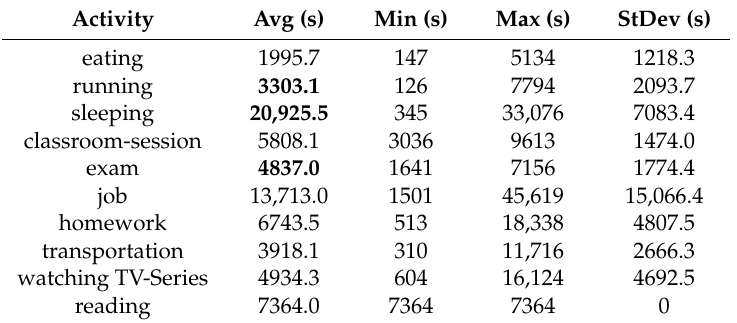
Table 3. Activity duration in second: average, minimum, maximum and standard deviation.